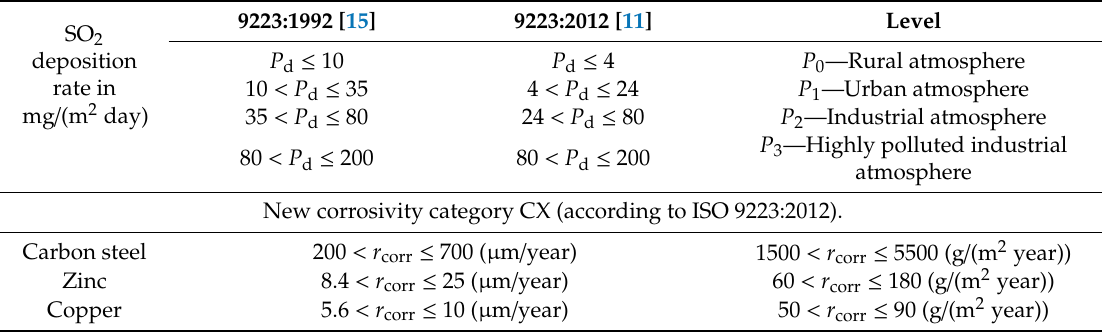
Table 7. Changes made between the first and the second editions of the ISO 9223